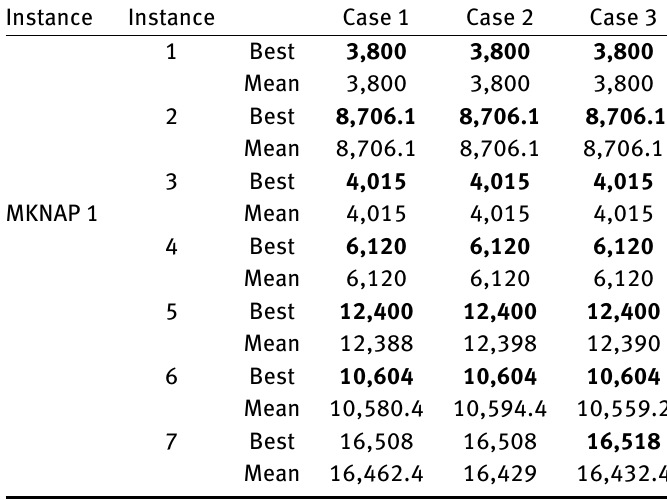
Table 5: Experimental results on effect of Crossover Rate on MKNAP 1 instances